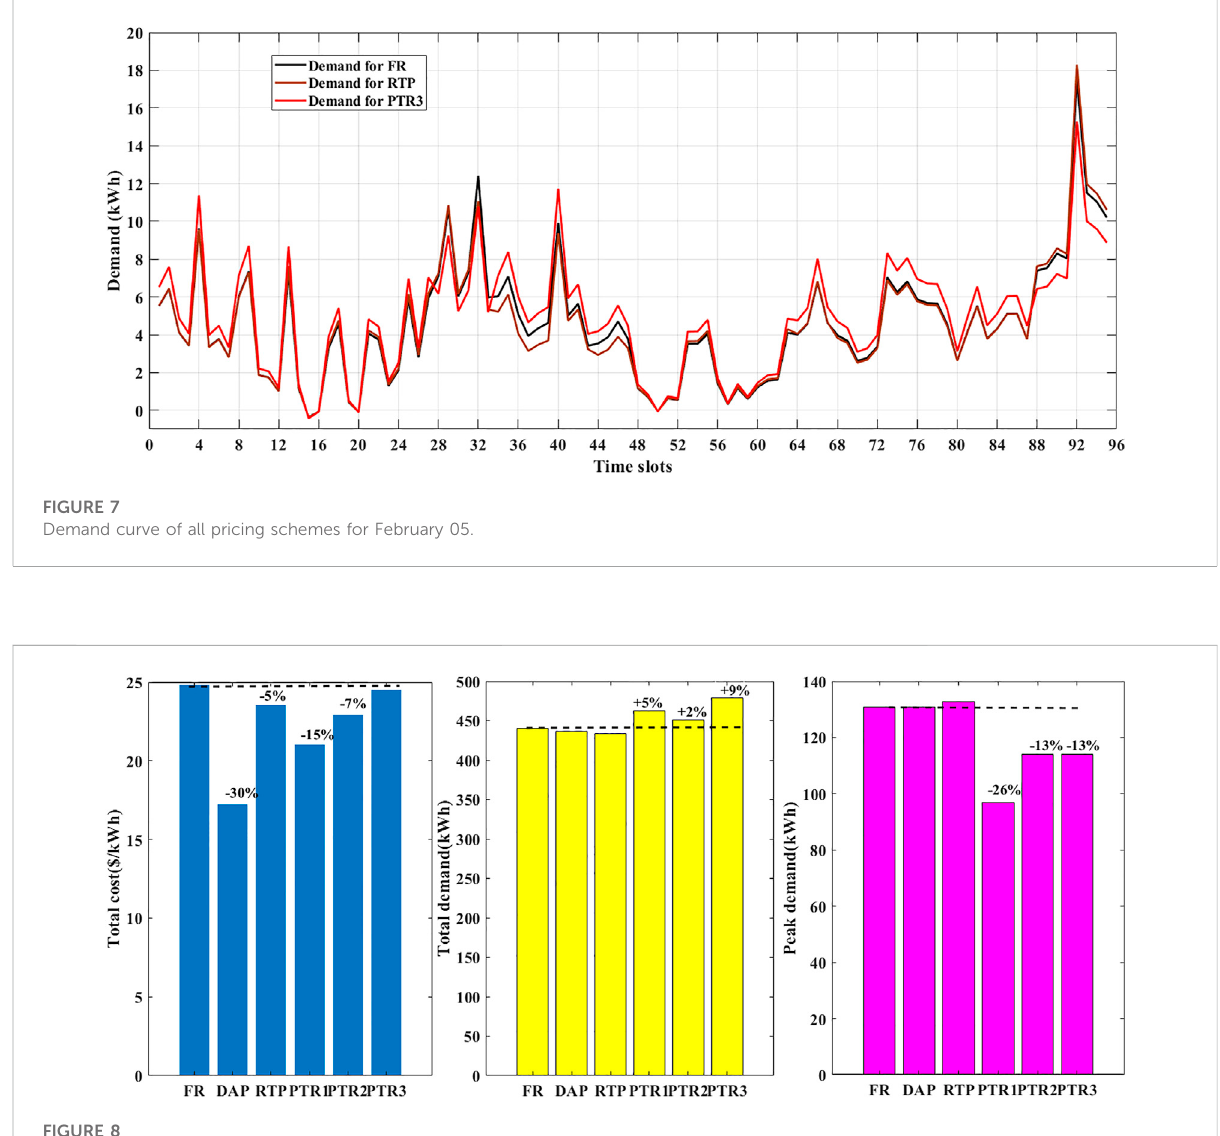
FIGURE 8 Bar chart of all parameters and all pricing schemes for February